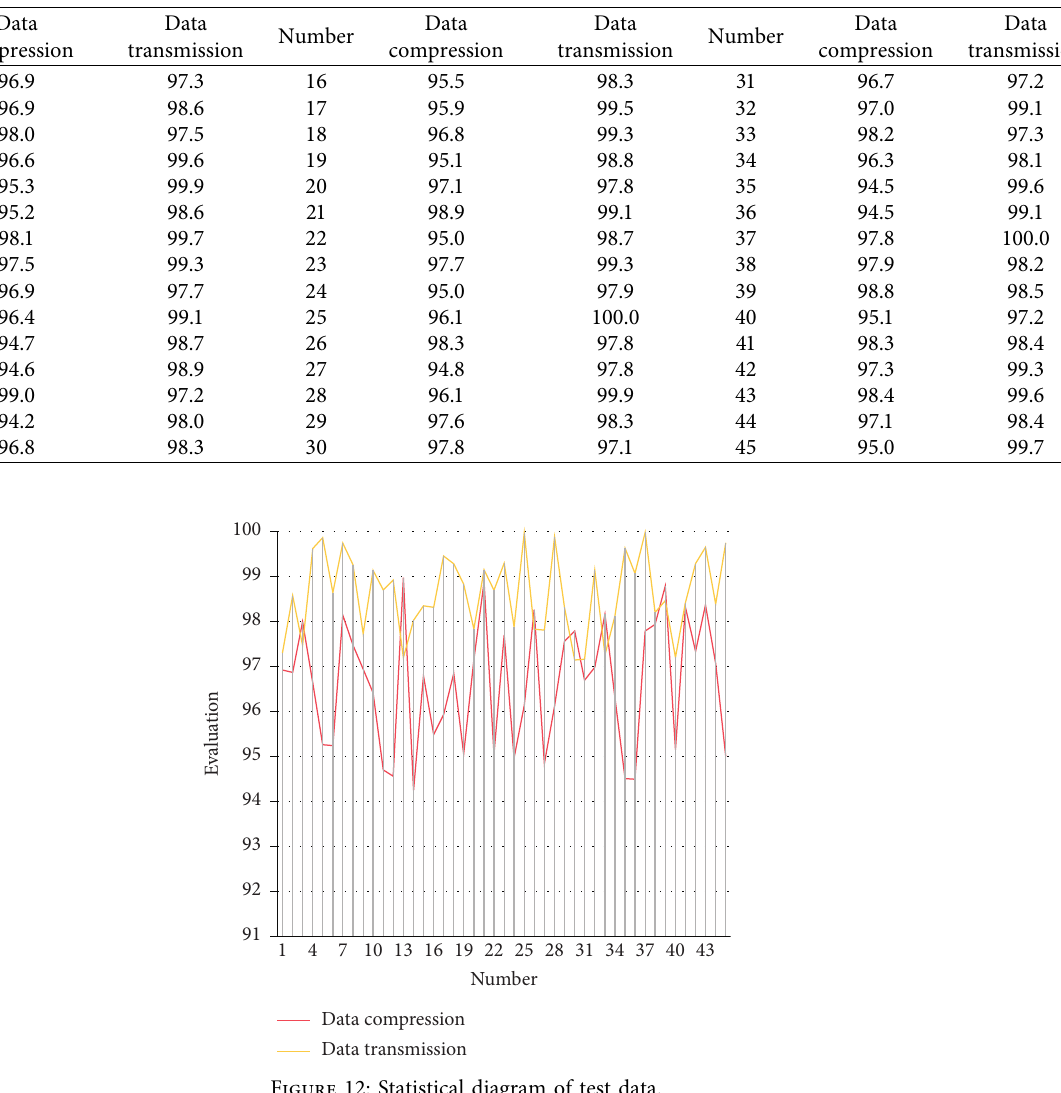
Table 2: Evaluation of the effect of the communication compression transmission system in the multimedia IoT environment integrating scene elements.